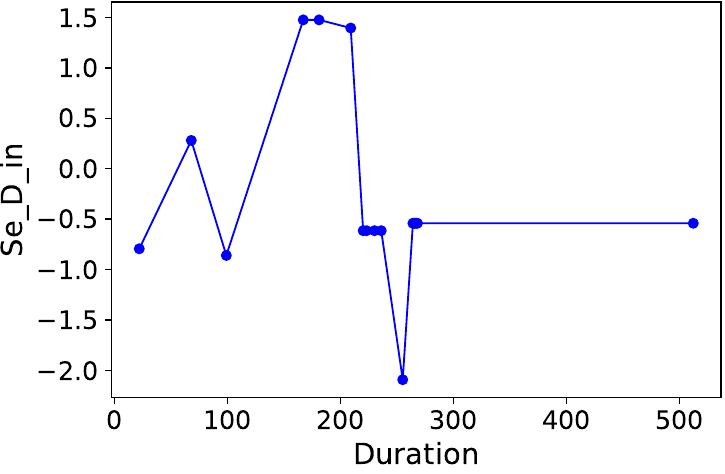
Figure A19. Normalized selenium inlet flowrate for Reactor 2.